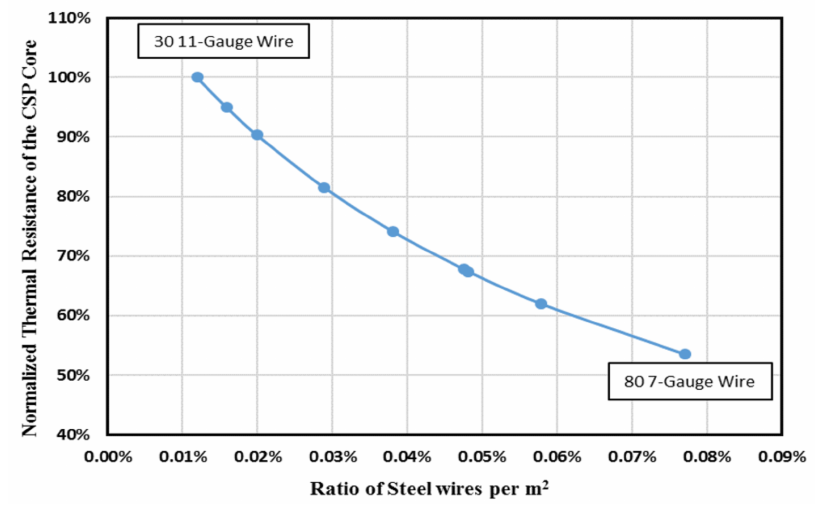
Figure 15. Correlation between shear transfer and thermal resistance of CSP panels.